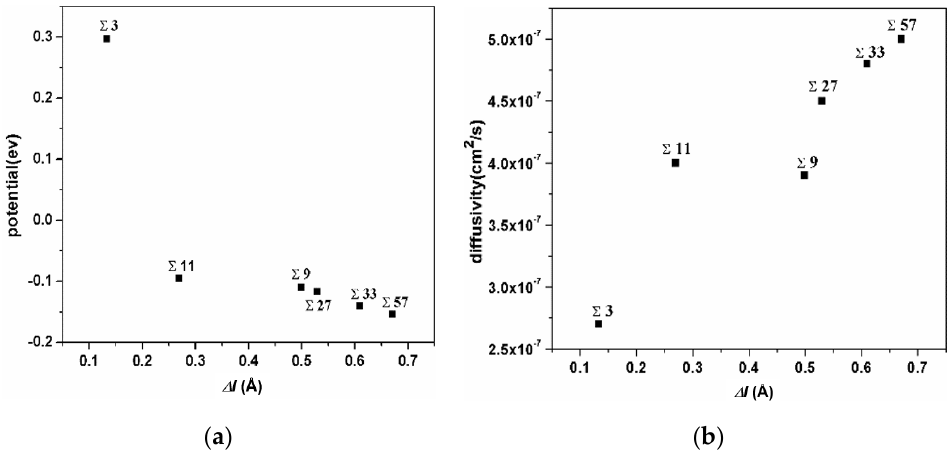
Figure 5. ( a ) the correlation of the extra volume of a specific GB versus the average of the potential energy of H atoms in it; ( b ) the correlation of the extra volume of a specific GB versus the diffusivity of H atoms in it.